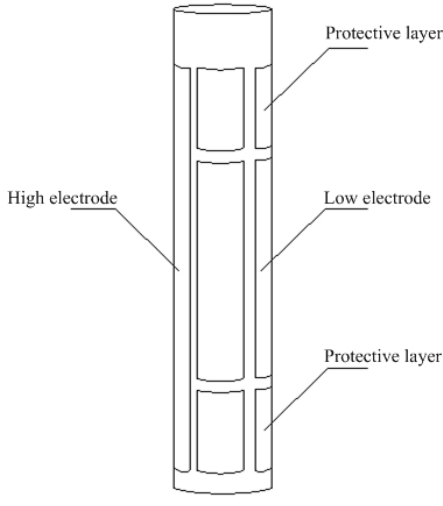
Figure 2. Schematic of the fuel-level sensor.